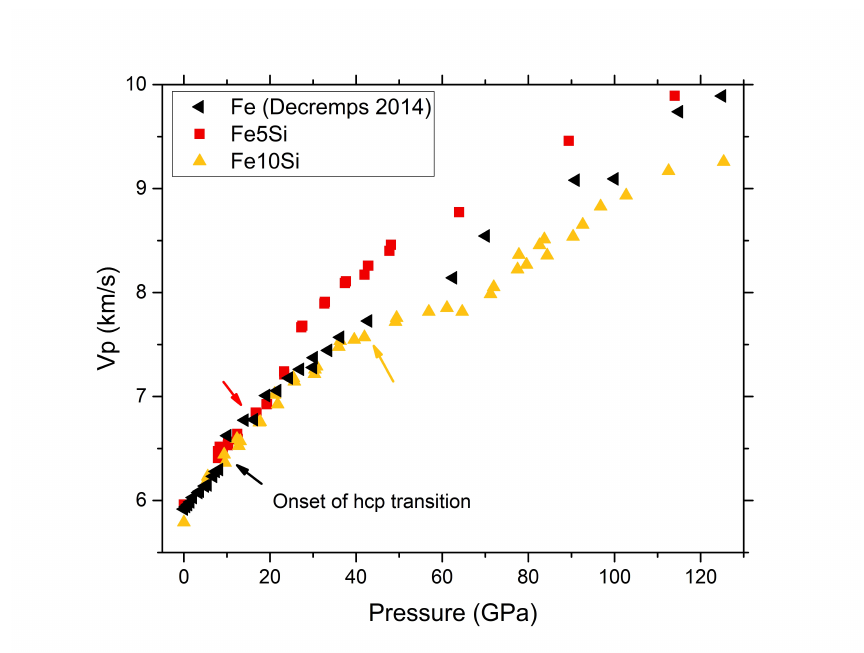
Figure 5. Vp vs. P for Fe (left triangles, labeled Fe [35]), Fe5Si (squares), and Fe10Si (up-triangles) compressed quasi-hydrostatically. While at the transition for Fe, there is a sharp increase in Vp, this does not occur in Fe5Si and Fe10Si, possibly due to a change in the bcc-hcp transition mechanism with Si addition [27]. Errors in Vp were about 2% up to 60 GPa, and up to 3% at higher pressures. A critical discussion of these results can be found in